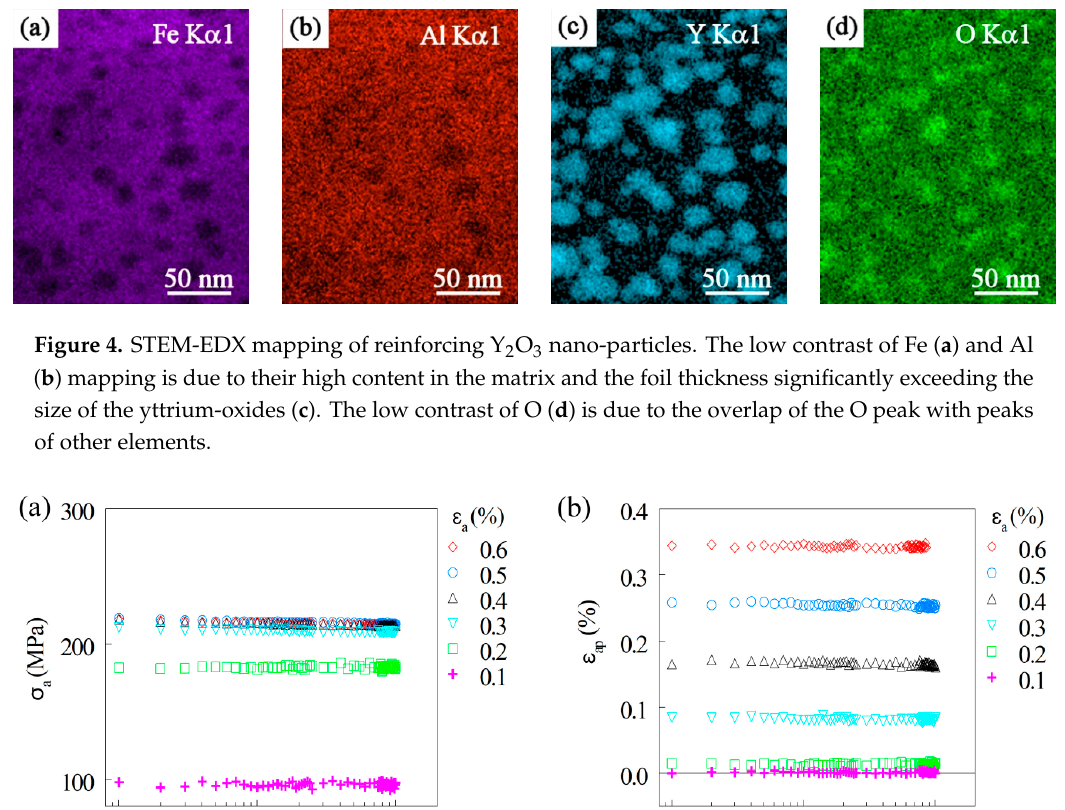
Figure 3. STEM micrographs of the ODS alloy (BF): ( a ) an overview and detail of Y 2 O 3 nano-particles in the left corner insertion; ( b ) dislocations (marked by white arrows) could be observed under certain diffraction conditions–B = [010] in the material after fatigue test termination.